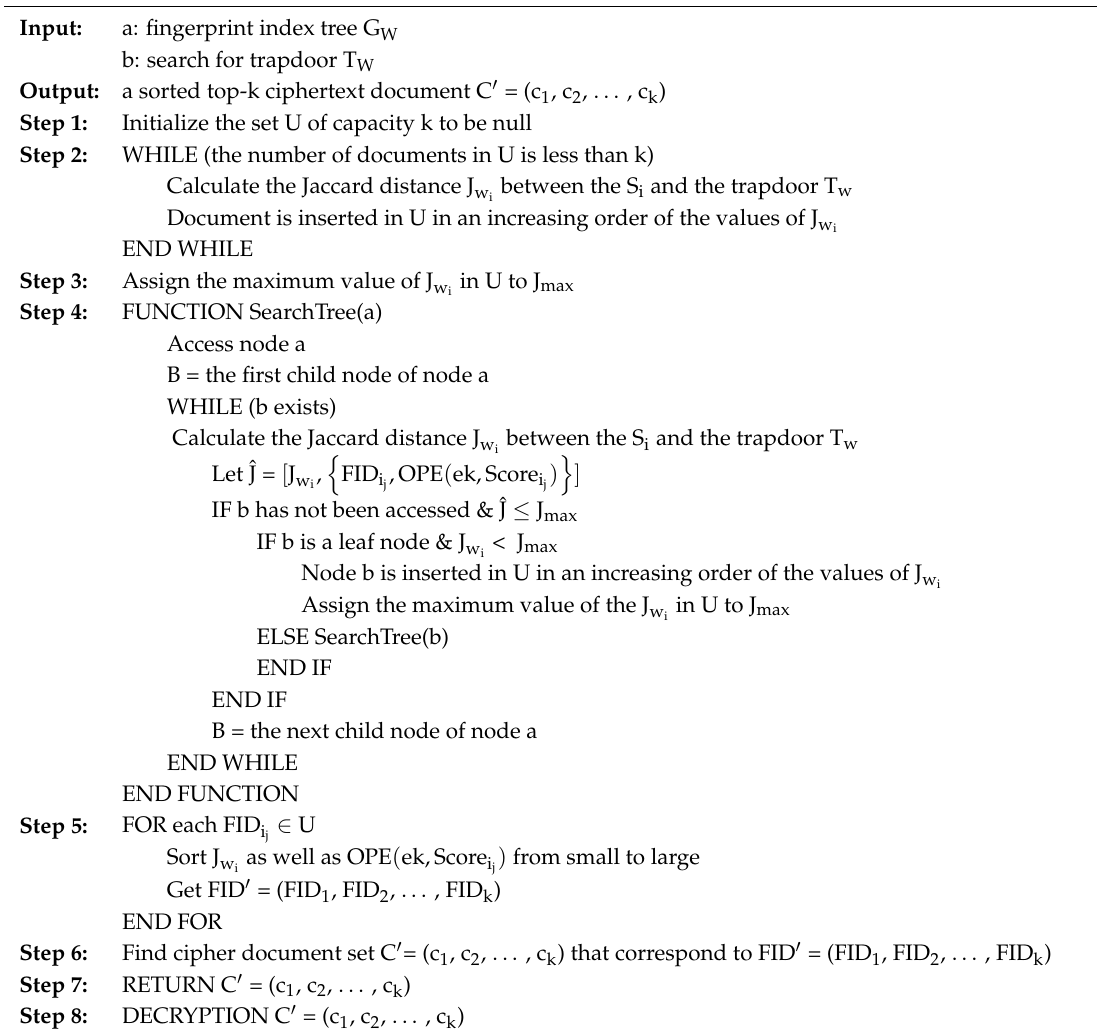
Algorithm 1. The New Method for Fingerprint Index Tree